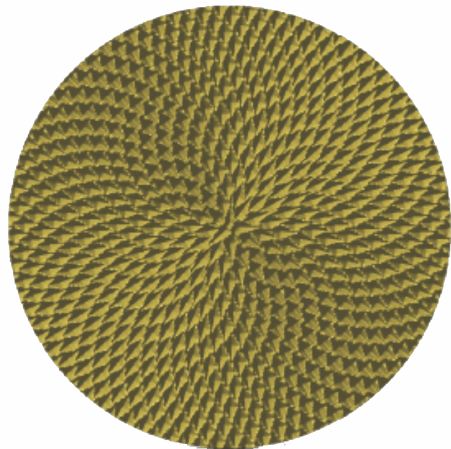
Fig. 5: Plot of the function given by Equation (5), replicating a sunflower seed head.